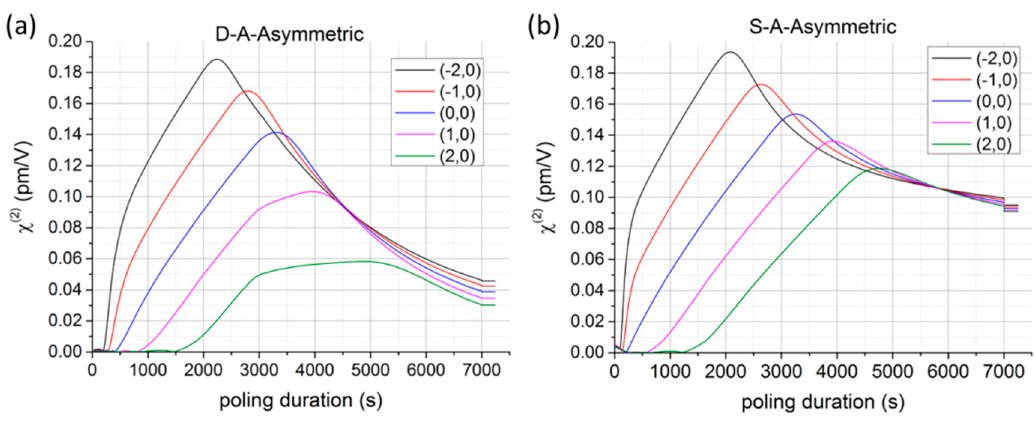
( 2 ) Figure 7. Time evolutions of the χ numerically obtained for a twin-hole fiber of asymmetric geometry χ numerically obtained for a twin-hole fiber of asymmetric Figure 7 : Time evolutions of the (2) ef f eff ( 2 ) poled in ( a ) D-A and ( b ) S-A configurations. The values of χ have been calculated via Equation (3) at χ have been calculated via ef f geometry poled in ( a ) D-A and ( b ) S-A configurations. The values of (2) eff five di ff erent locations in the fiber’s core region (4 µ m diameter) and in the plane Y = 0. The legend ( 2 ) Equation (3) at five different locations in the fiber’s core region (4 µm diameter) and in the plane Y = shows the (x,y) coordinates (in µ m) of the points where the values of χ have been calculated ef f χ have been 0. The legend shows the (x,y) coordinates (in µm) of the points where the values of (2) eff calculated [45].